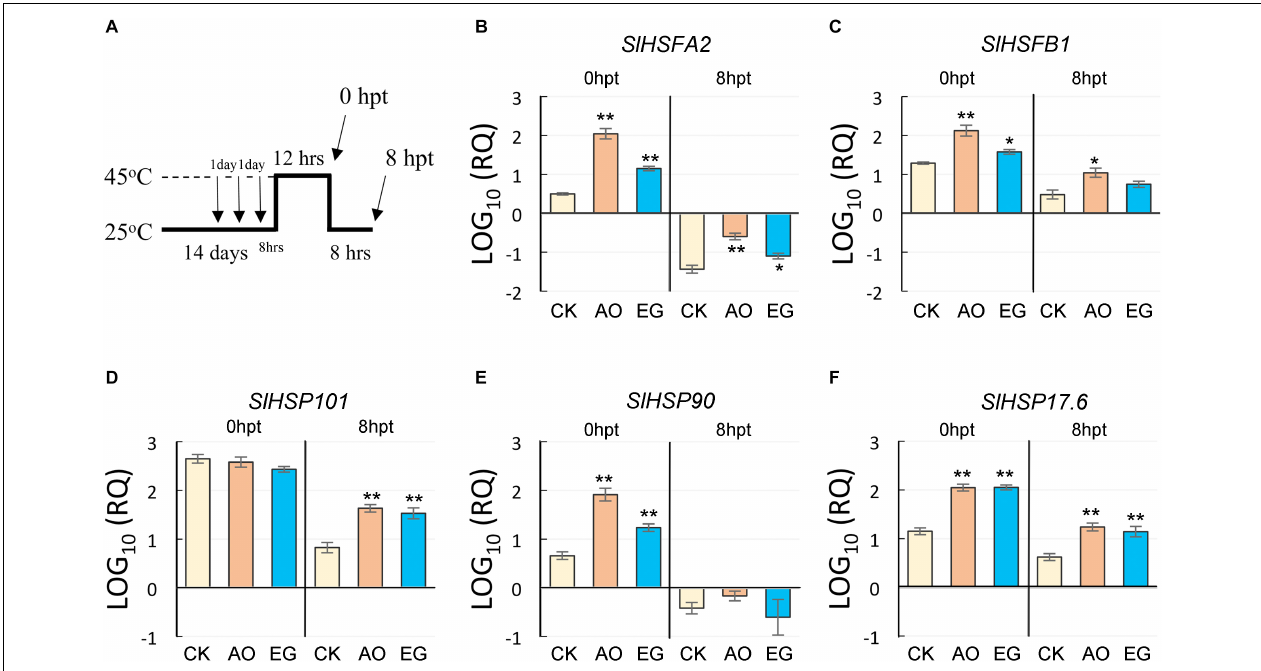
FIGURE 2 | Effects of anise oil and eugenol on the expression of HSFs and HSPs in tomato plants under heat stress. Fourteen-day-old tomato seedlings treated with a control solution (CK), anise oil (AO), or eugenol (EG) for 24 h were subjected to heat stress at 45 ◦ C for 12 h. After heat treatment (0 hpt) and 8-h recovery (8 hpt), total RNA was extracted from these plants (A) . The SlHSFA2 (B) , SlHSFB1 (C) , SlHSP101 (D) , SlHSP90 (E) , and SlHSP17.6 (F) expression levels were analyzed by RT-qPCR. The β -actin expression level was used as the internal control. Relative gene expression levels were normalized against the expression level in untreated tomato plants. Data were analyzed with the 2 − (cid:49)(cid:49) Ct method. Bars represent the mean ( ± standard error of the mean) of three independent biological replicates each with three technical replicates. Significant differences between control and anise oil- or eugenol-treated plants were assessed with Student’s t -test ( ∗ P < 0.05; ∗∗ P <